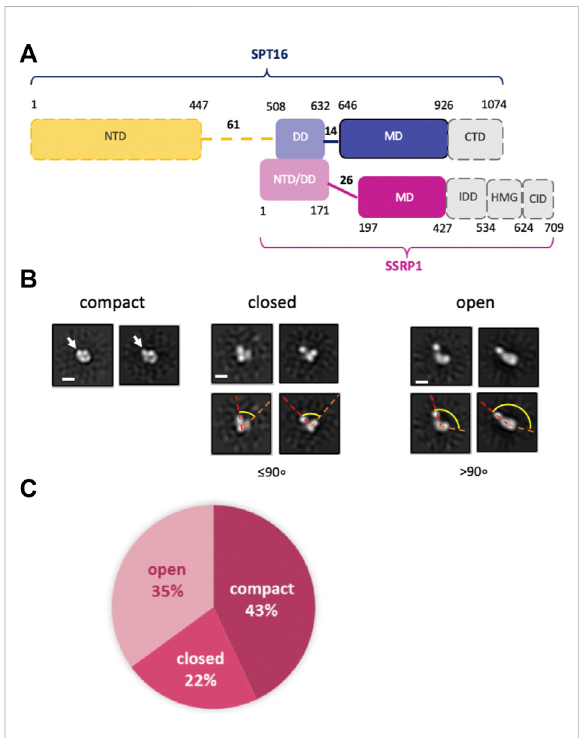
FIGURE 1 Human FACT is a fl exible protein complex. (A) Human FACT domain architecture. Gray domains with dashed boundaries are expected to be disordered and were not detected by cryo-EM (). Domain abbreviations: NTD — N-terminal, DD — dimerization, MD — middle, CTD — C-terminal, HMG — high mobility group box, IDD — intrinsically disordered, CID — CTD-Interacting domain, (B) Characteristic 2D class averages of FACT in compact, closed and open conformations: the arrow indicates the domain, that is, detectable only in the compact conformation, dashed lines highlight the angle between the domains, which increases as the complex opens. (C) Distribution (%) of FACT in different conformations. Bar — 10